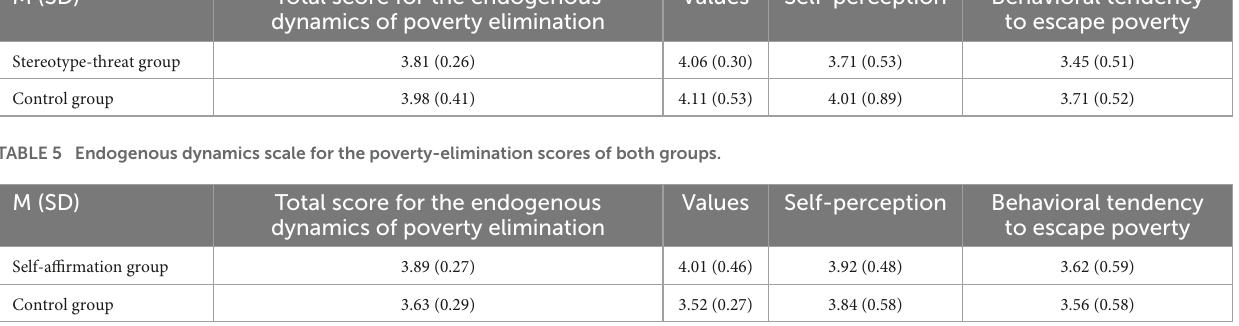
TABLE 4 Endogenous dynamics of poverty elimination in the two groups. M (SD)